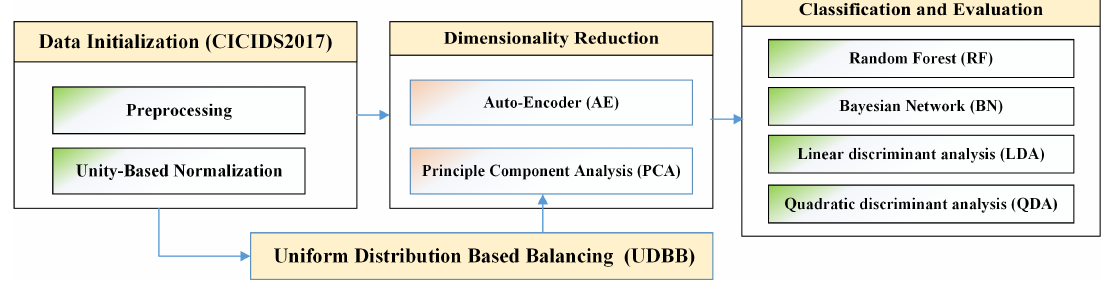
Figure 1. Proposed